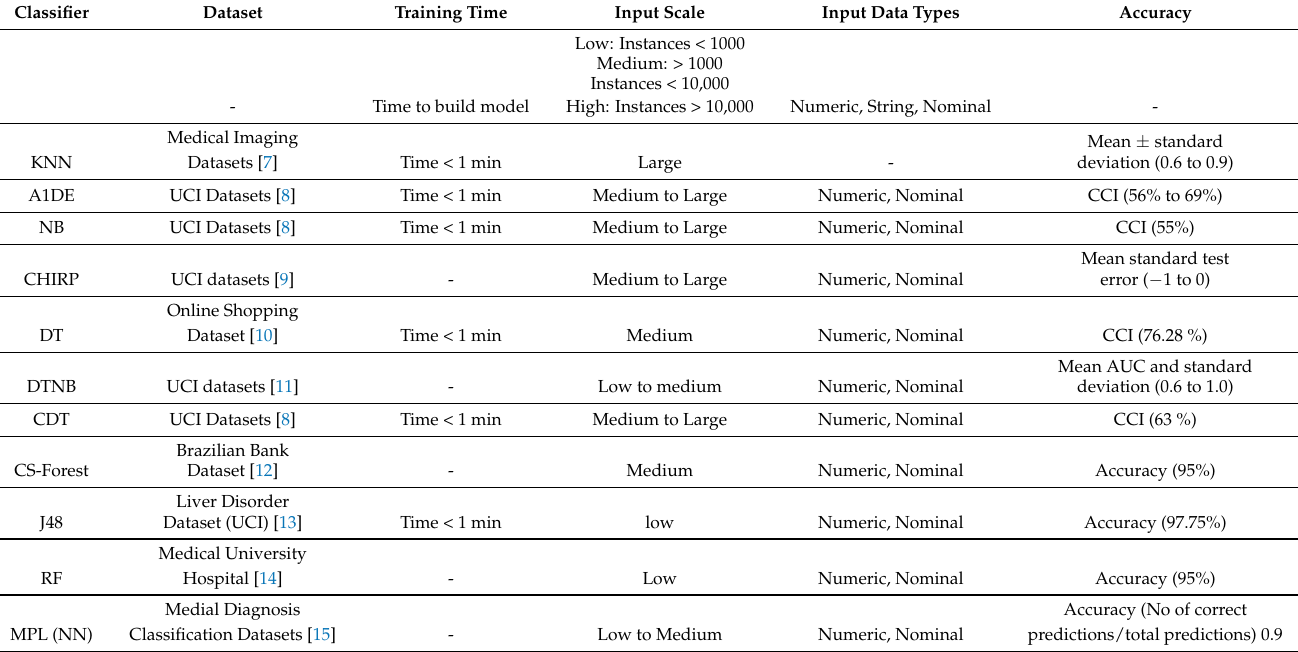
Table 1. Selection of for ML